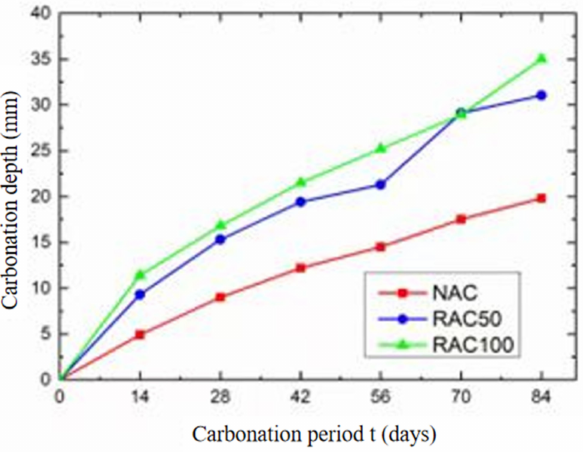
Figure 4. Carbonation depth versus carbonation